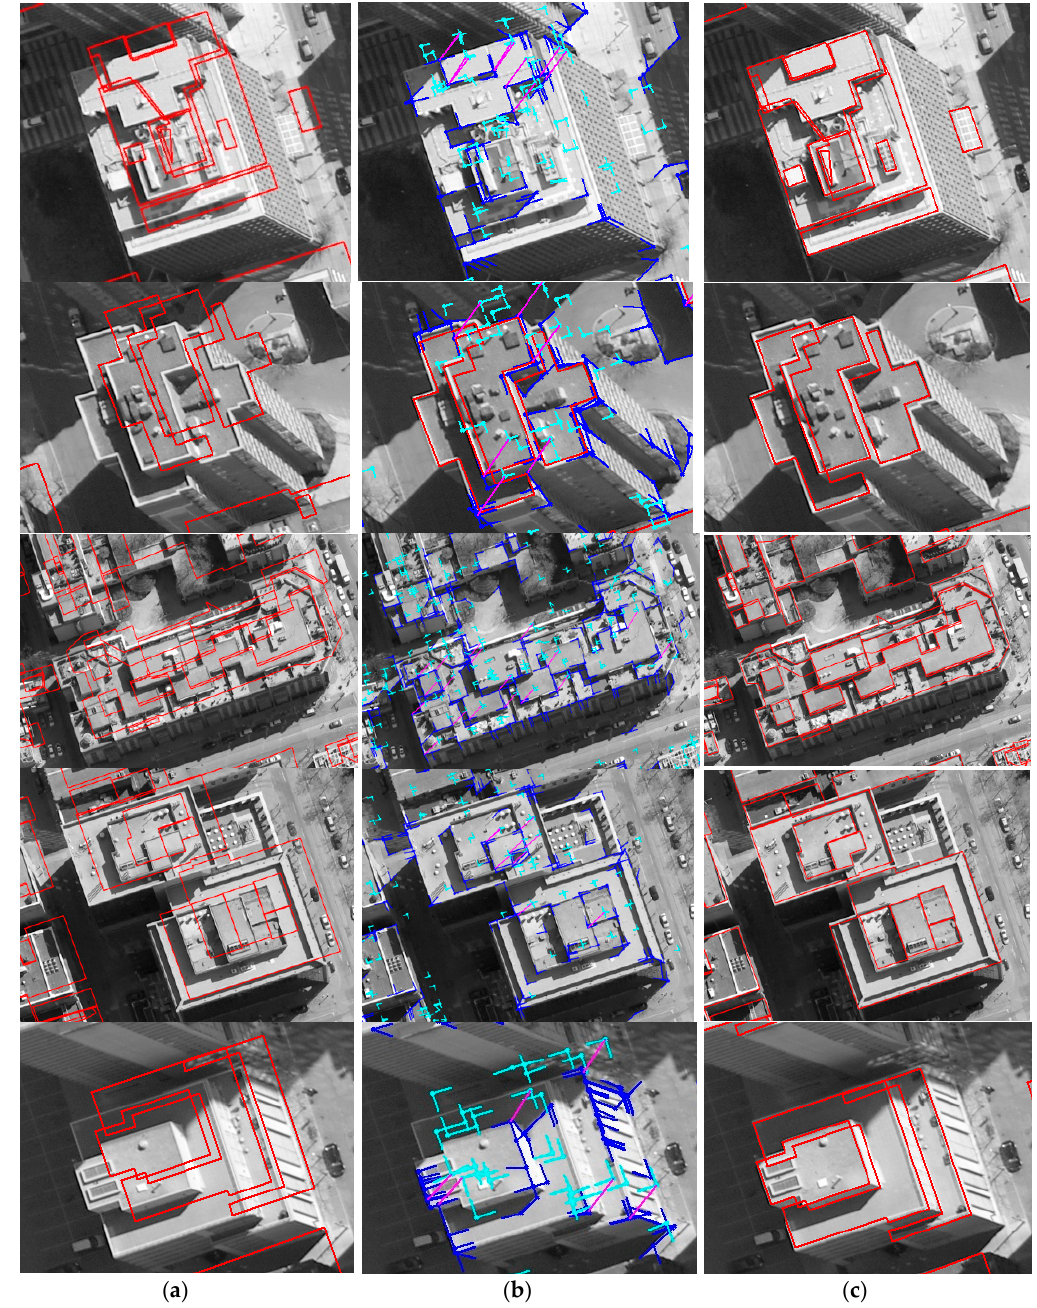
Figure 12. LiDAR-driven building models: ( a ) with error-contained EOPs; ( b ) matching relations (purple) between edged corner features extracted from the image (blue) and from the models (cyan), and ( c ) with refined EOPs. Table 4. Quantitative assessment with check points (unit: pixel).